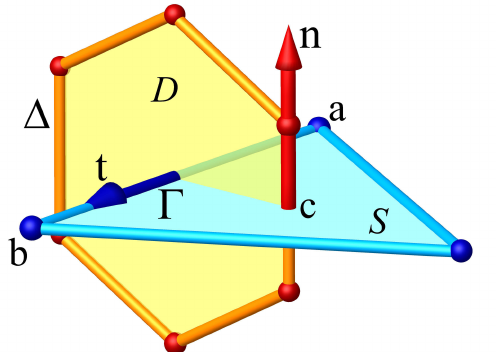
Figure 2. Geometric structures of discrete mechanics: the primal structure (in blue) is composed of a collection of segments Γ oriented by a unit vector t bounded by the ends a or b ; these segments form a polygonal planar surface S , whose barycenter, denoted c , defines the normal n that is positively oriented according to Maxwell’s rule. The dual structure (in red) has a flat polygonal surface D bounded by segments ∆ . The unit vectors are orthogonal by construction, n · t =